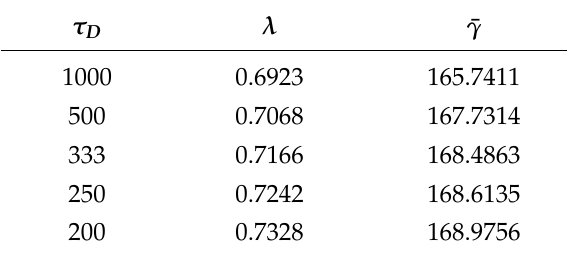
Table 4. λ and ¯ γ for various τ D with given T α = 2 ± 0.1.